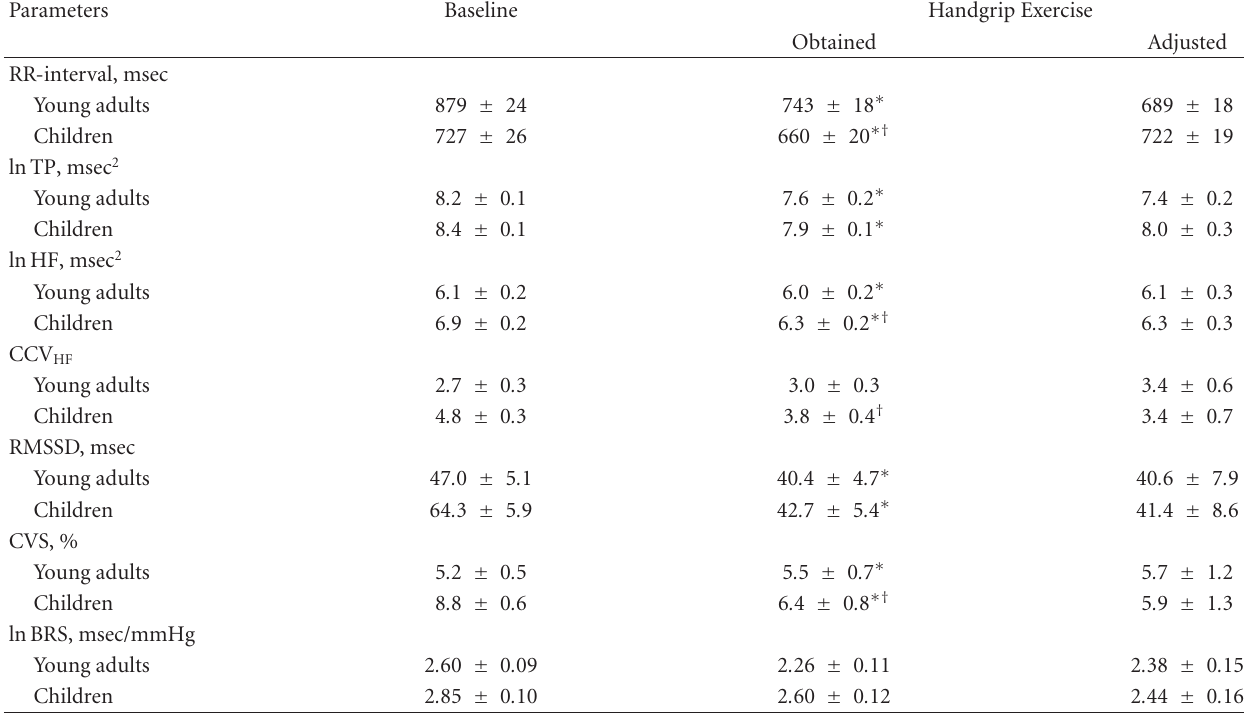
Table 3: Cardiovagal modulation and baroreflex sensitivity in response to isometric handgrip